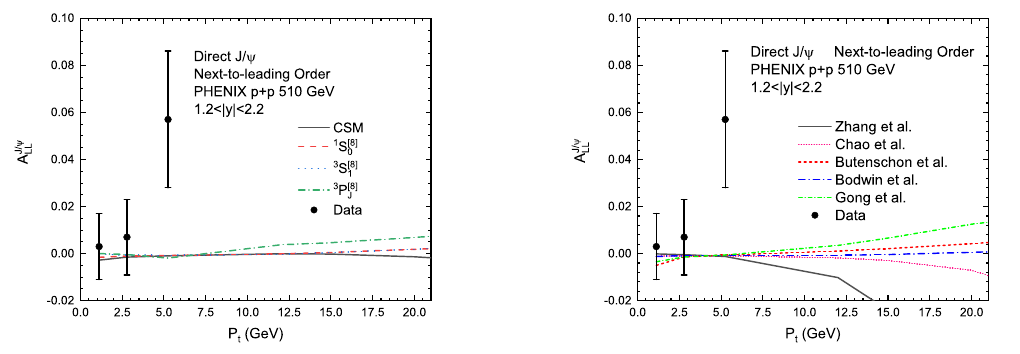
Figure 2 . The double longitudinal asymmetry A J/ψ The data points are from ref. [42].